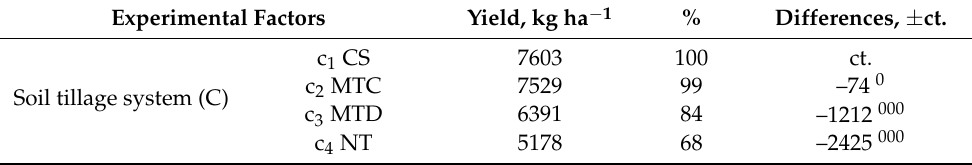
Table 7. Influence of the tillage system on maize average yield, 2016–2021. Experimental Factors Yield, kg ha − 1 % Differences, ±